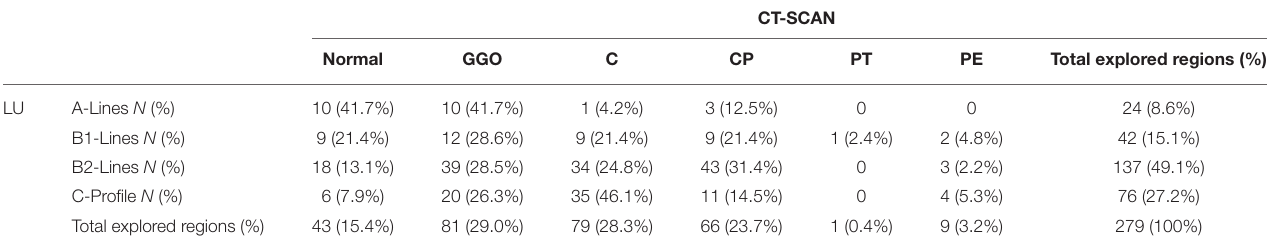
TABLE 2 | Description of all thoracic regions explored by LU and CT scan.